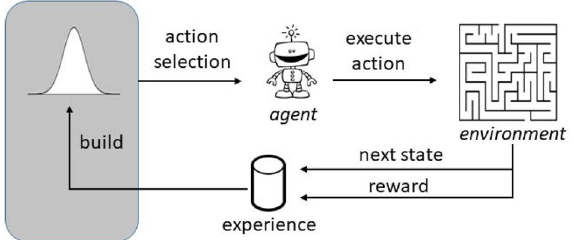
Figure 1. Sketch of the Q-learning cycle. An agent is schematically represented, performing a Q-learning cycle; namely, taking an action to solve a problem, getting back a reward and possibly changing its state and, finally, building a new probability distribution (by using the algorithm we are proposing), from which the next action is